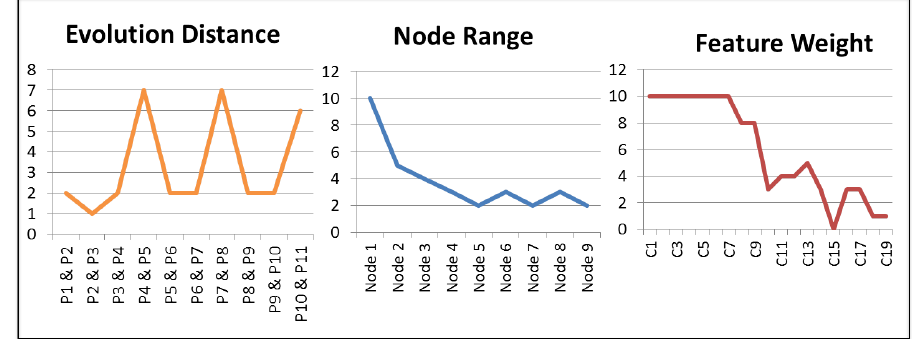
Figure 3. Measures calculation for mobile media